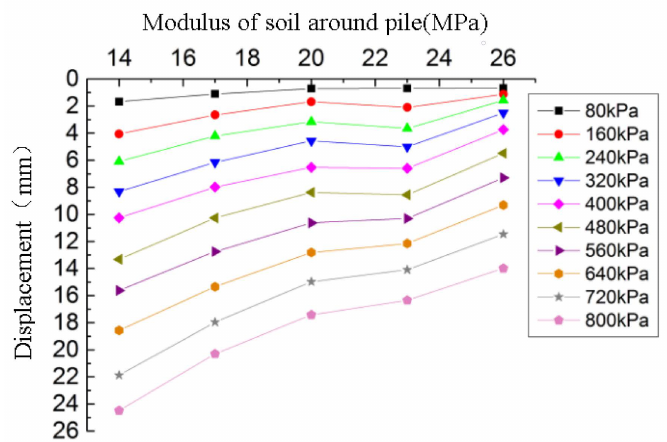
Figure 22. The elastic modulus of the soil effect on the curve of settlement.